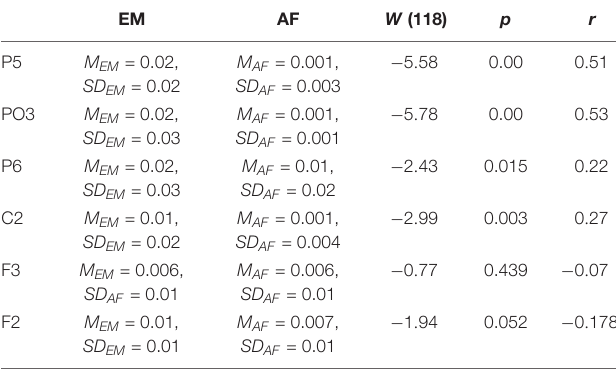
TABLE 4 | Estrogen–male storyteller versus